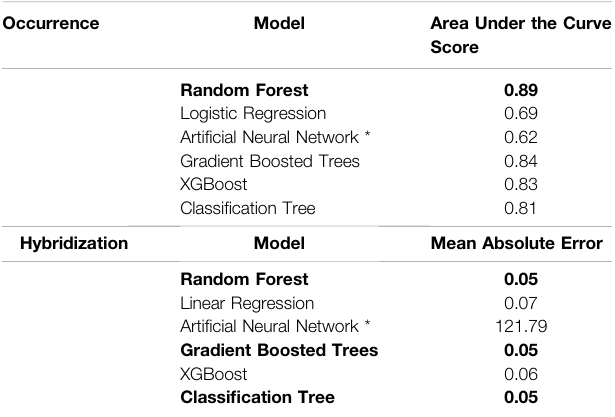
TABLE 2 | Predictive capability of each ensemble model. Bold indicates highest accuracy models. Asterisk indicates models that were removed due to unrealistic